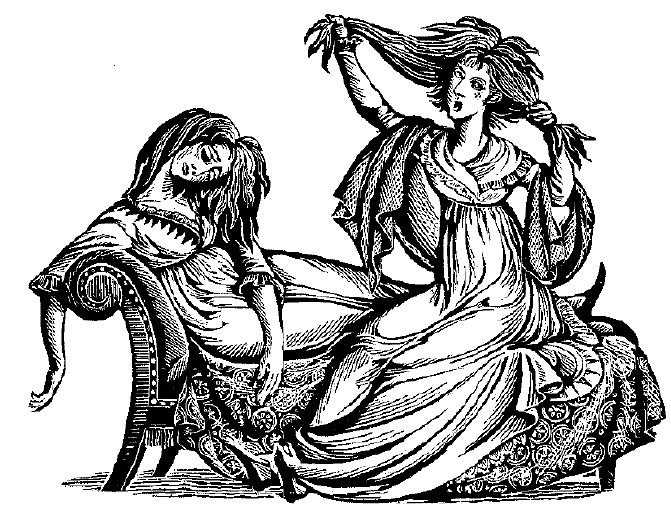
Figure 7. Joan Hassall’s illustration for ‘Love and Freindship’ (Austen 1975), p. 96. Courtesy of The Estate of Joan